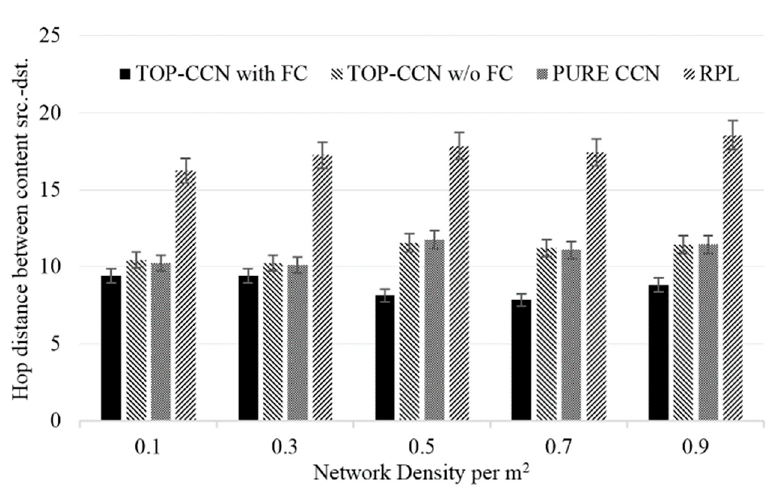
Figure 8. Cumulative end to end packet delivery ratio.